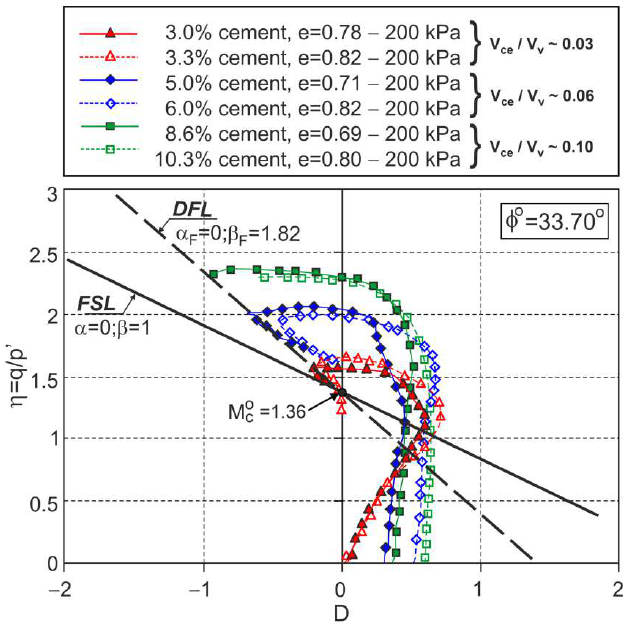
Figure 8. Stress ratio–dilatancy relationships for the drained triaxial compression of fine sand with different volumes of cement and different cement–void ratios (adapted from [27]). Used with permission of the American Society of Civil Engineers, ASCE, from Influence of Cement–Voids Ratio on Stress-Dilatancy Behaviour of Artificially Cemented Sand., Consoli, N. C.; Cruz, R. C.; Viana da Fonseca, A.; Coop, M. R., J. Geotech. Geoenviron. Eng. 138 (1), 2012, [doi:10.1061/(ASCE)GT.1943-5606.0000565]; permission conveyed through Copyright Clearance Center, Inc.